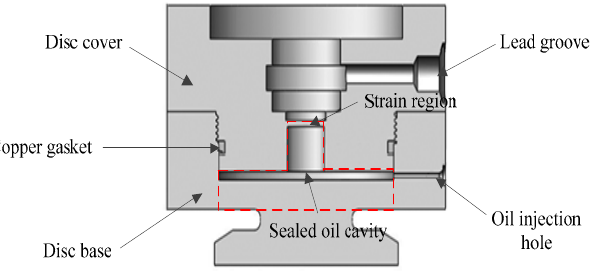
Figure 3. Structure diagram of the acoustic filtering sensor.